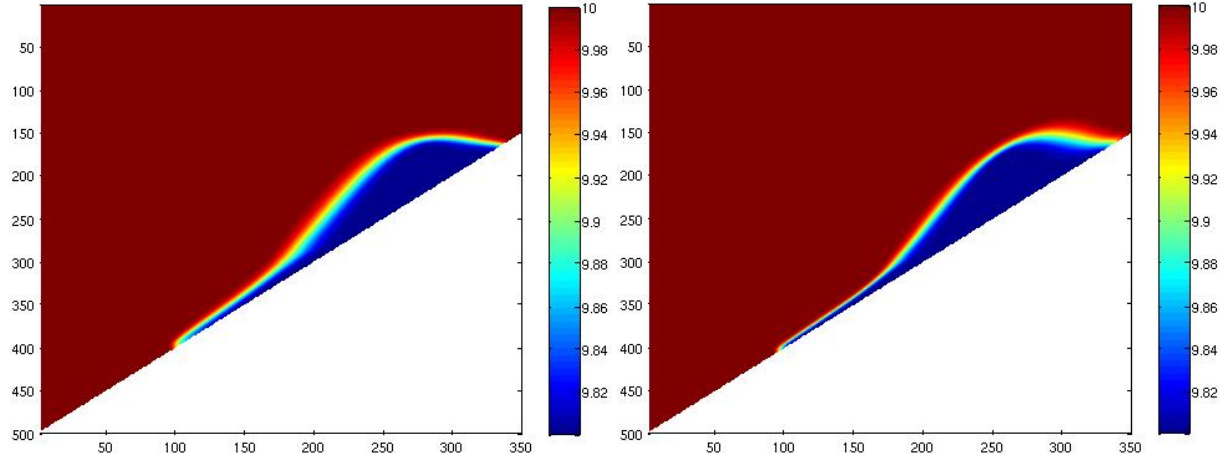
Fig. 2. Temperature structure (in C o ) in the reference simulations after 7 days; left: z-coordinate (G01) and right: σ -coordinate (G02). Coordinates give grid in the x-direction and the z-direction for the z-coordinate grid. For the σ -coordinate results are interpolated to the z-coordinate grid (in the z-direction).